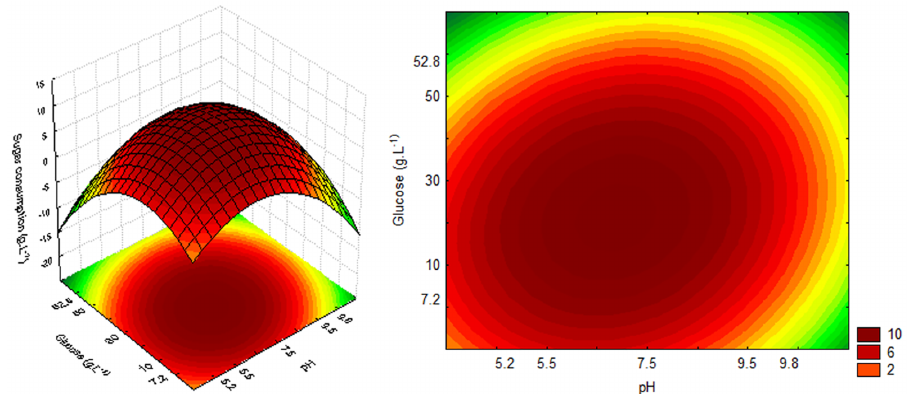
Fig 7. Response and contour surfacesas a function of glucose concentration and pH for sugar